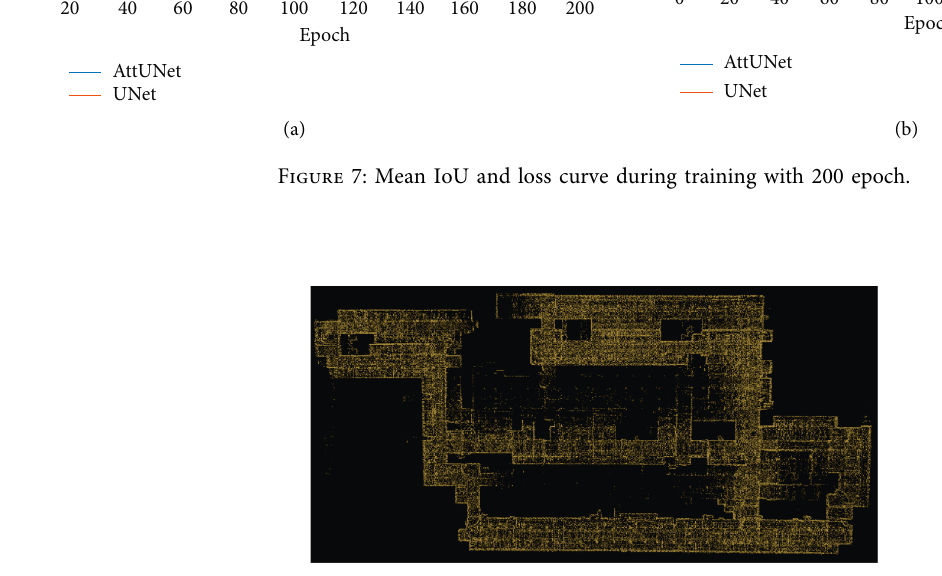
Figure 8: Point cloud map by Lidar.